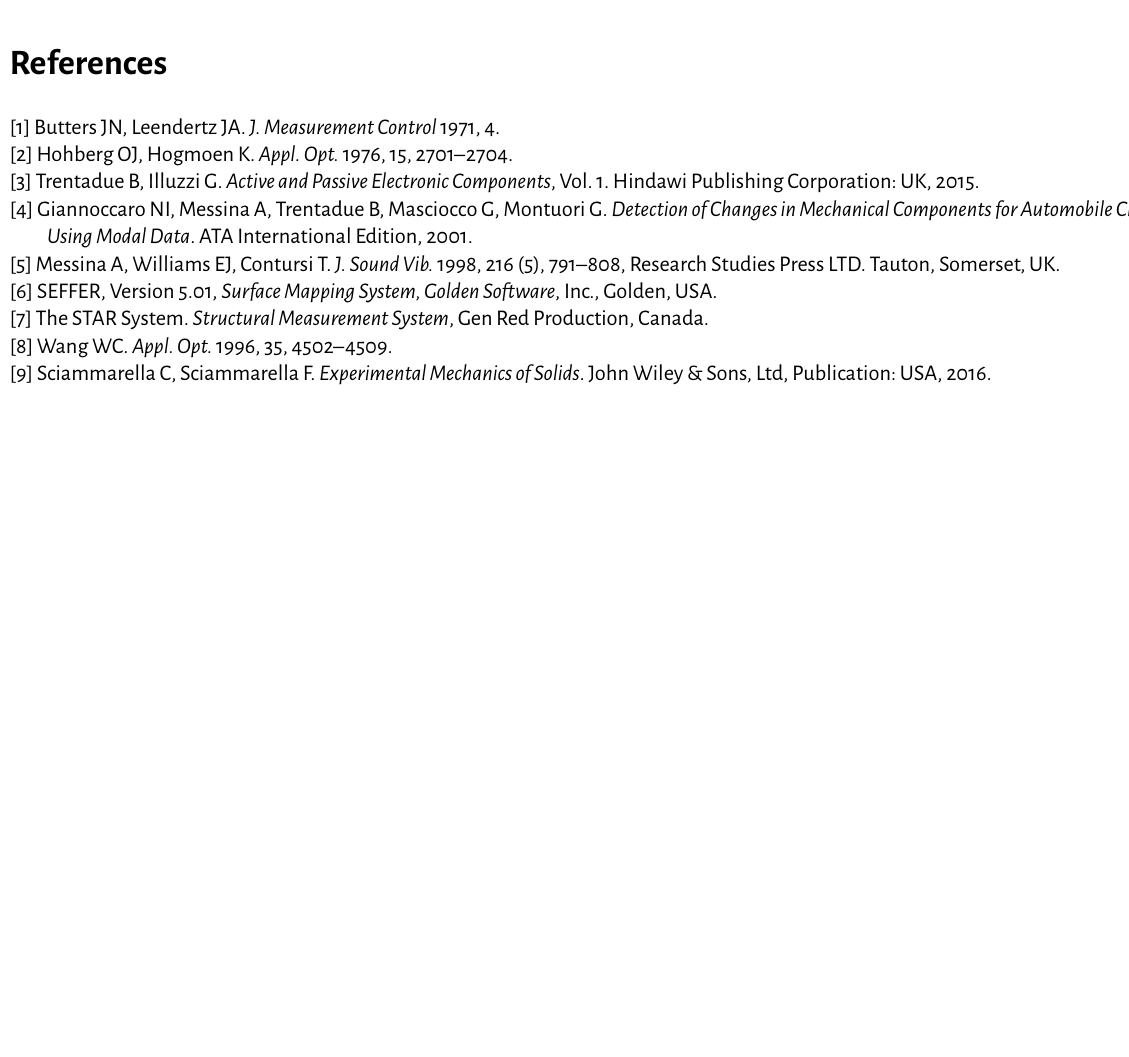
Figure 8: Transmissibility